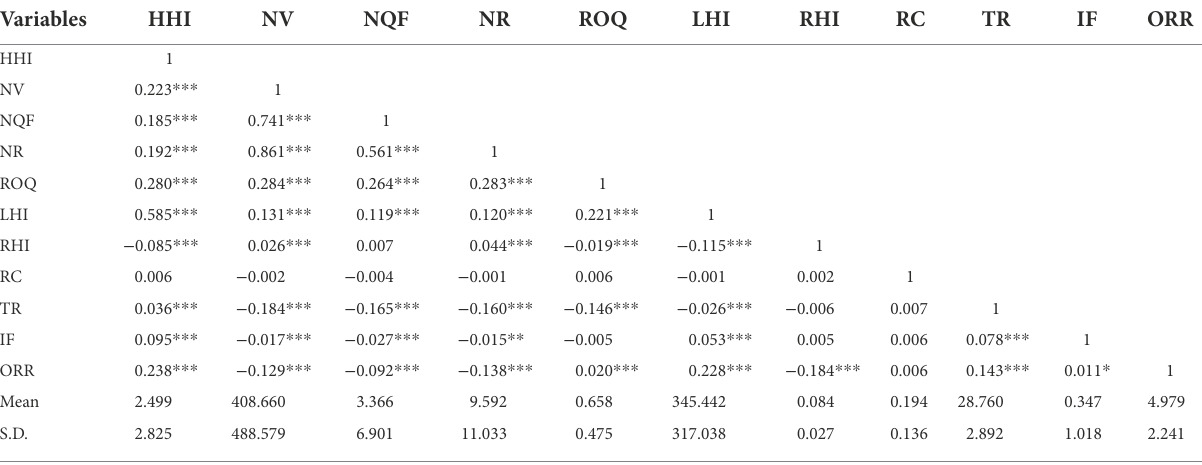
TABLE 2 Results of descriptive statistics and covariance matrix.